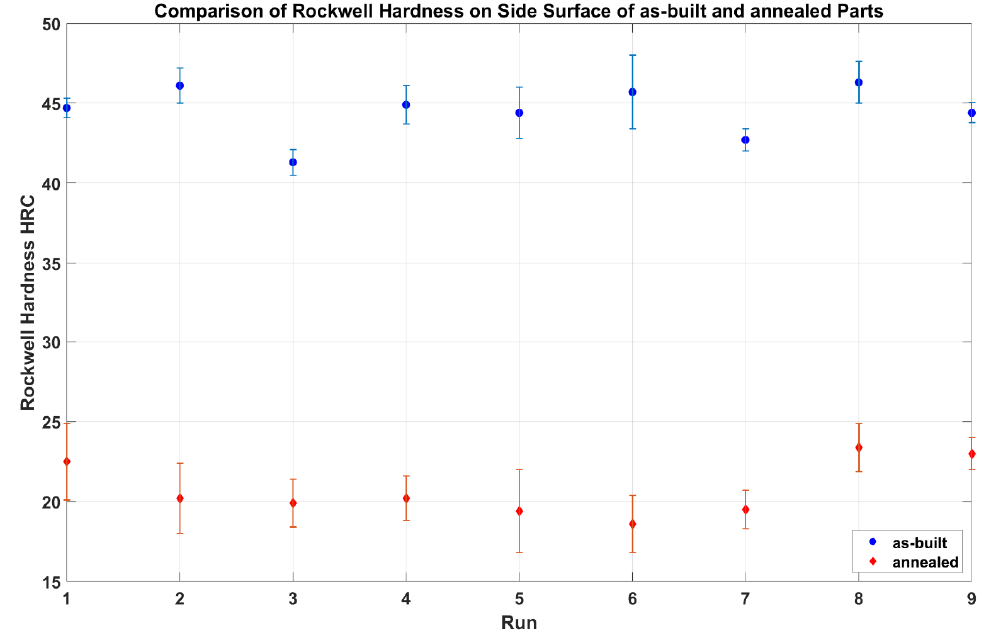
Figure 17. Effect of annealing on Rockwell hardness HRC on the side surface.